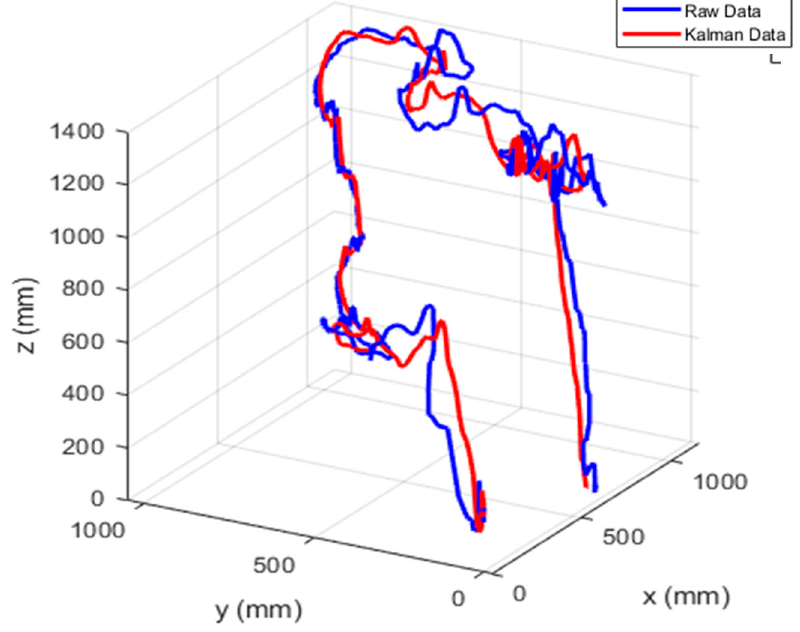
Figure 14. A 3-min flight with random maneuvers.